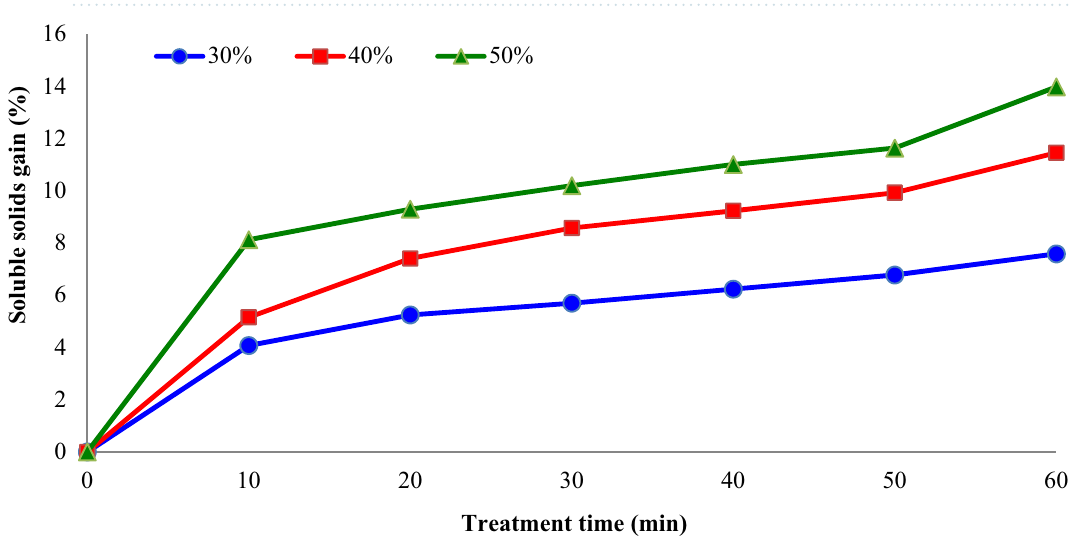
Figure 3. Impacts of sonication power and treatment time on the soluble solids gain (%) of apple slices during osmotic dehydration (concentration = 40° Brix).